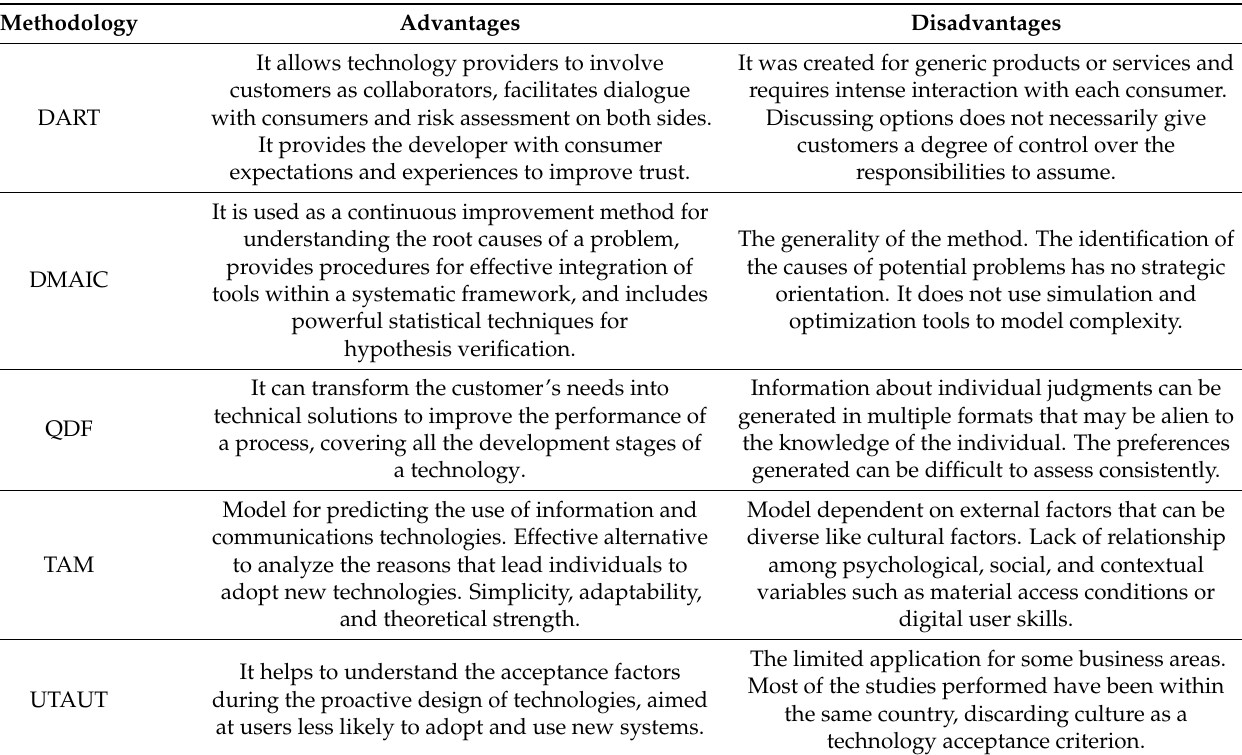
Table 1. Advantages and disadvantages of ICT validation